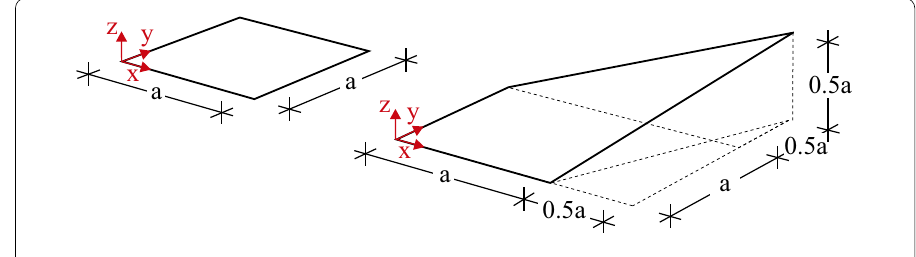
Fig. 1 Element shapes for the eigenvalue analysis